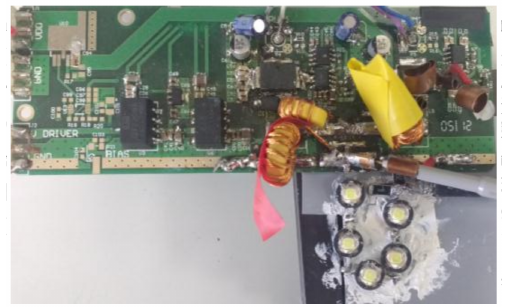
Figure 14. Prototype of the implemented two-phase buck converter with a fourth-order output filter and five